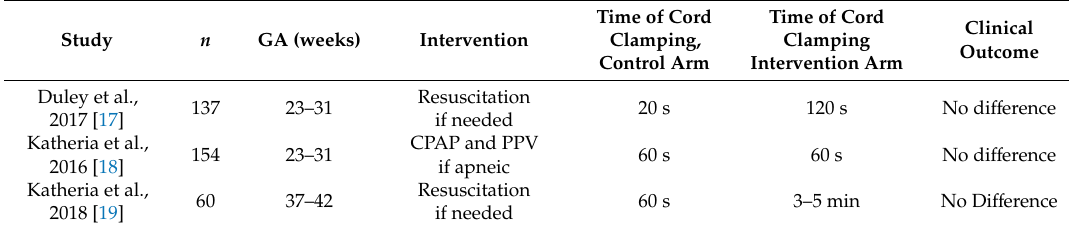
Table 1. Completed trials of neonatal resuscitation with an intact